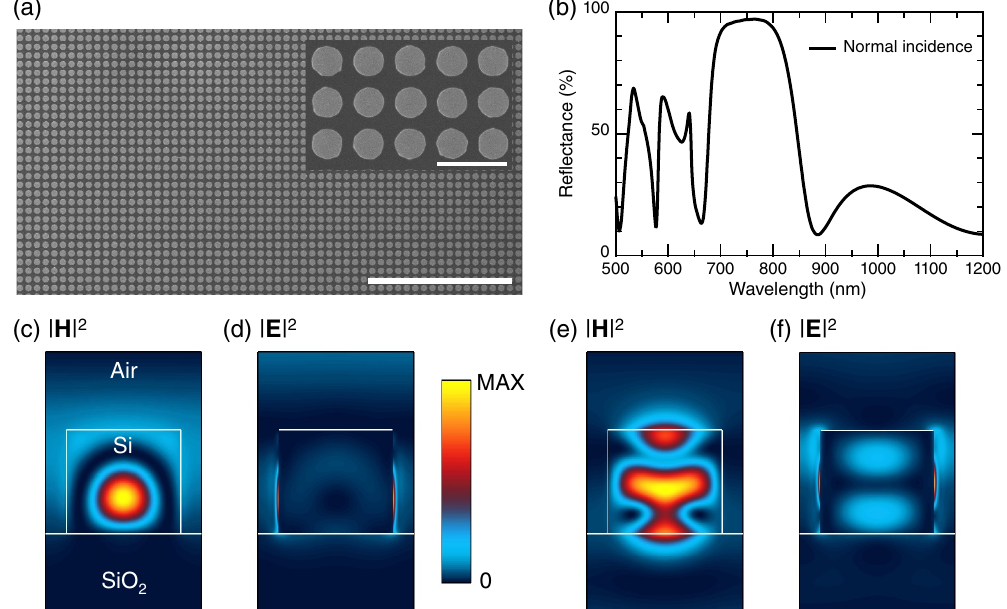
Figure 2. Structure, optical properties, and resonances of all-dielectric metasurfaces. ( a ) SEM image in wide view. The white bold scale bar indicates 5 µ m. The inset is shown in a magnified view with a white scale bar of 500 nm as well. The periodicity of the metasurface is 300 nm and diameter of the Si nanorod is 220 ± 3 nm. ( b ) Reflectance spectrum at normal incidence, which was numerically simulated. ( c , d ) Respective resonant magnetic and electrical field intensities at 765.1 nm. The vertical section view through the center of the Si nanorod is shown together with the color bar. ( e , f ) Respective resonant magnetic and electrical field intensities at 576.5 nm, shown in a similar manner to ( c , d